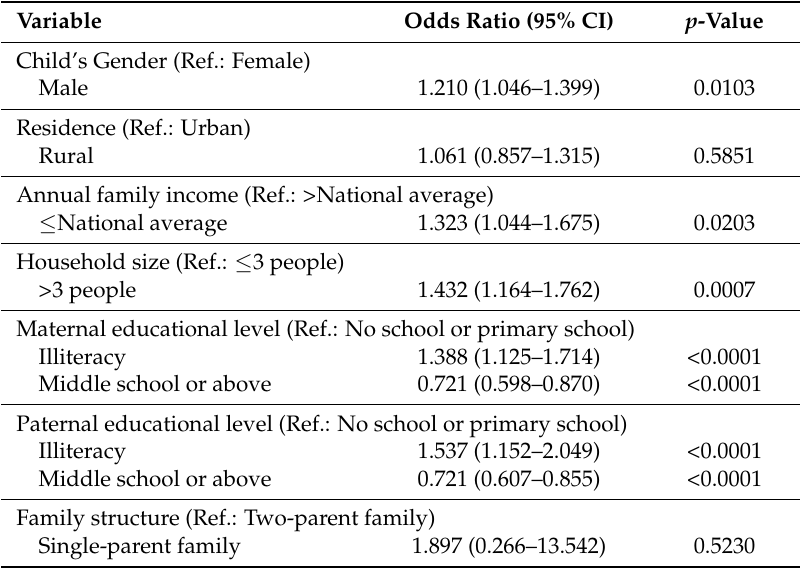
Table 4. Parental social level on the risk of hearing impairment among Chinese children (hearing impairment vs. healthy